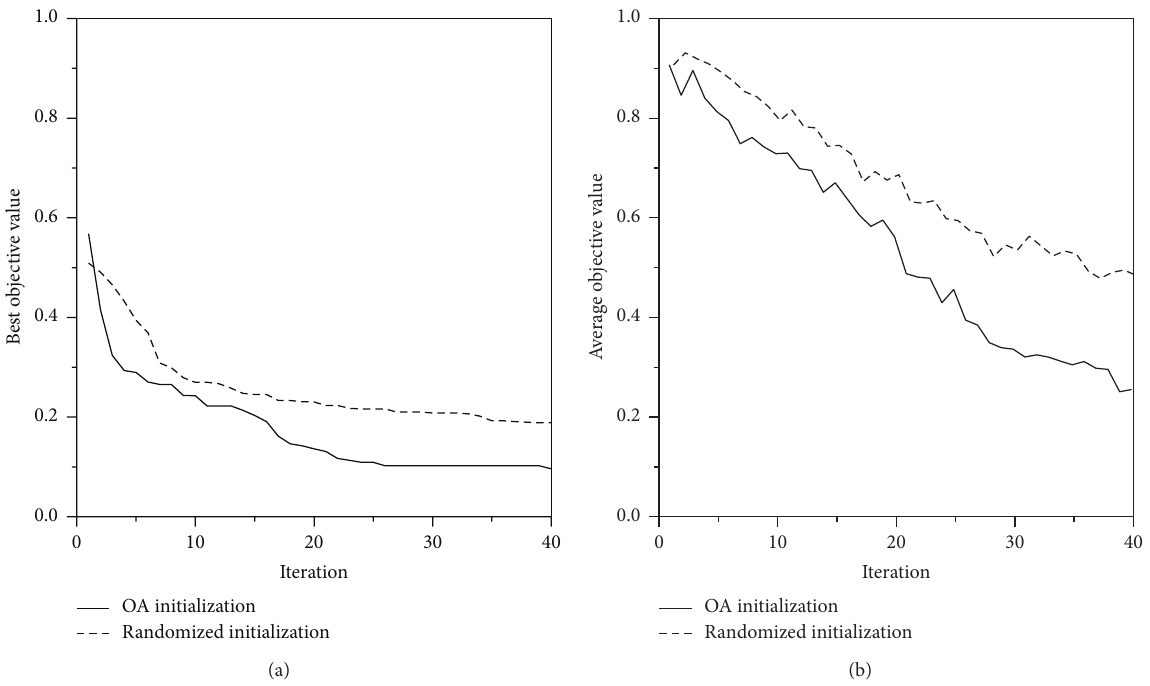
Figure 11: Convergence histories of (a) best objective value and (b) average objective value for the randomized initialization and the OA initialization.